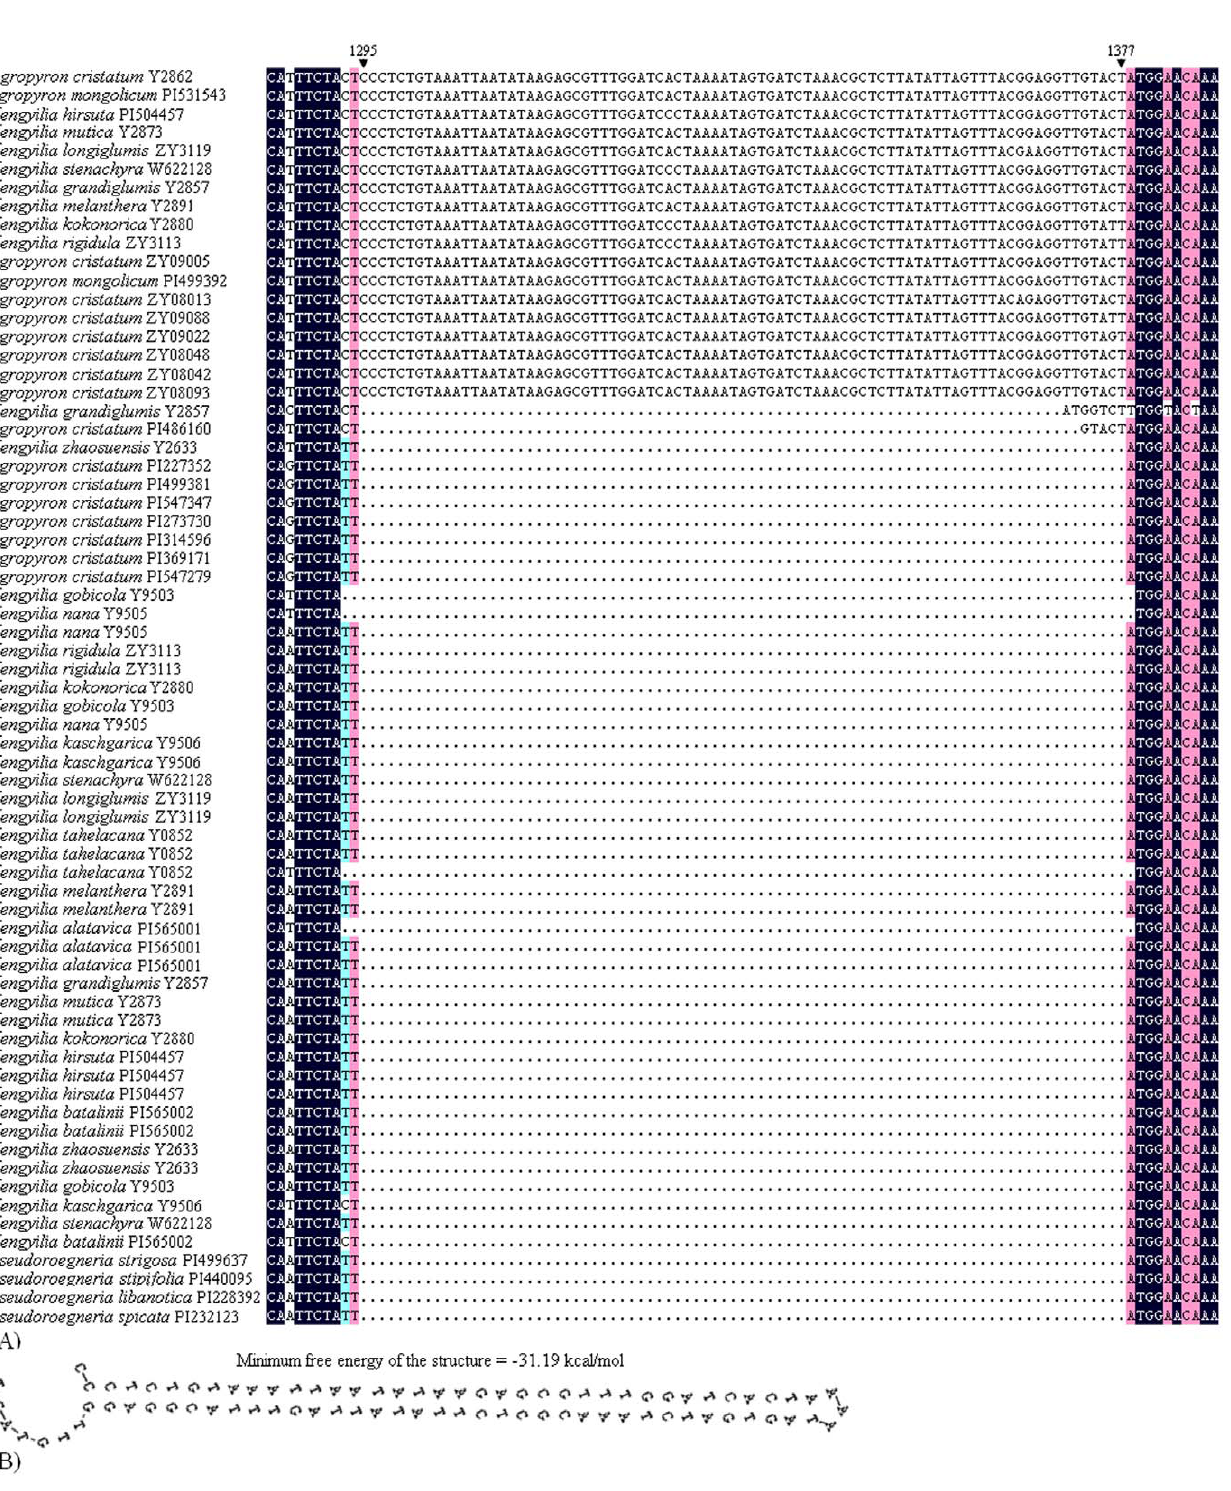
Agropyron . The Tajima [34] and Fu and Li’s [37] tests were conducted on each of eight data sets (Table S2). Tajima’s and Fu and Li’s D values of the P genome lineage from the Qinghai-